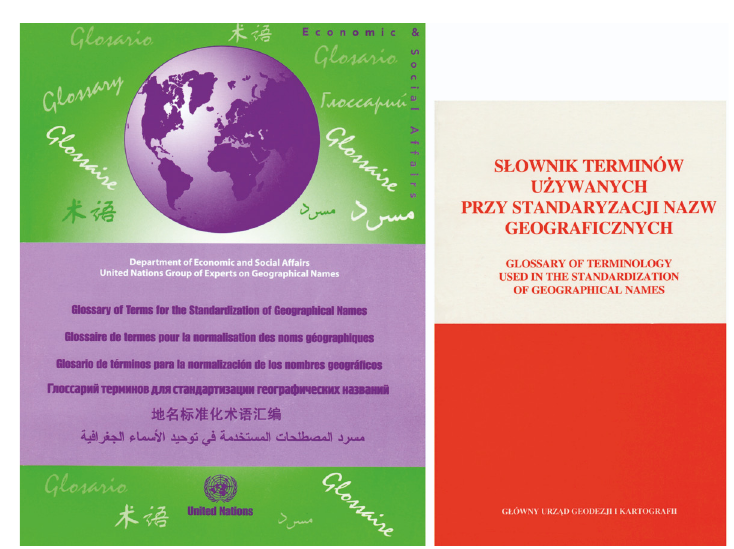
Fig. 3. Glossary of Terms for the Standardization of Geographical Names – UNGEGN publication of 2002 in six official languages of the UN and the Polish edition of